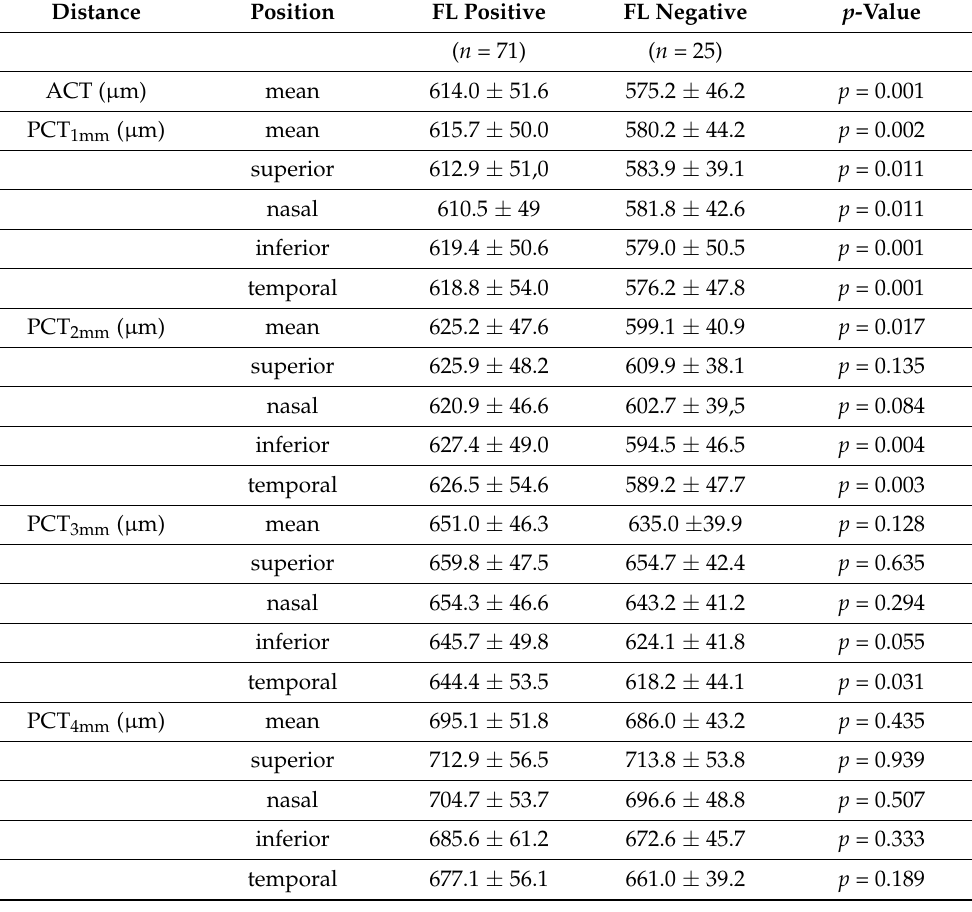
Table 3. Corneal thickness in fibrillar layer (FL)-positive and -negative advanced FECD eyes. Apex corneal thickness (ACT), peripheral corneal thickness